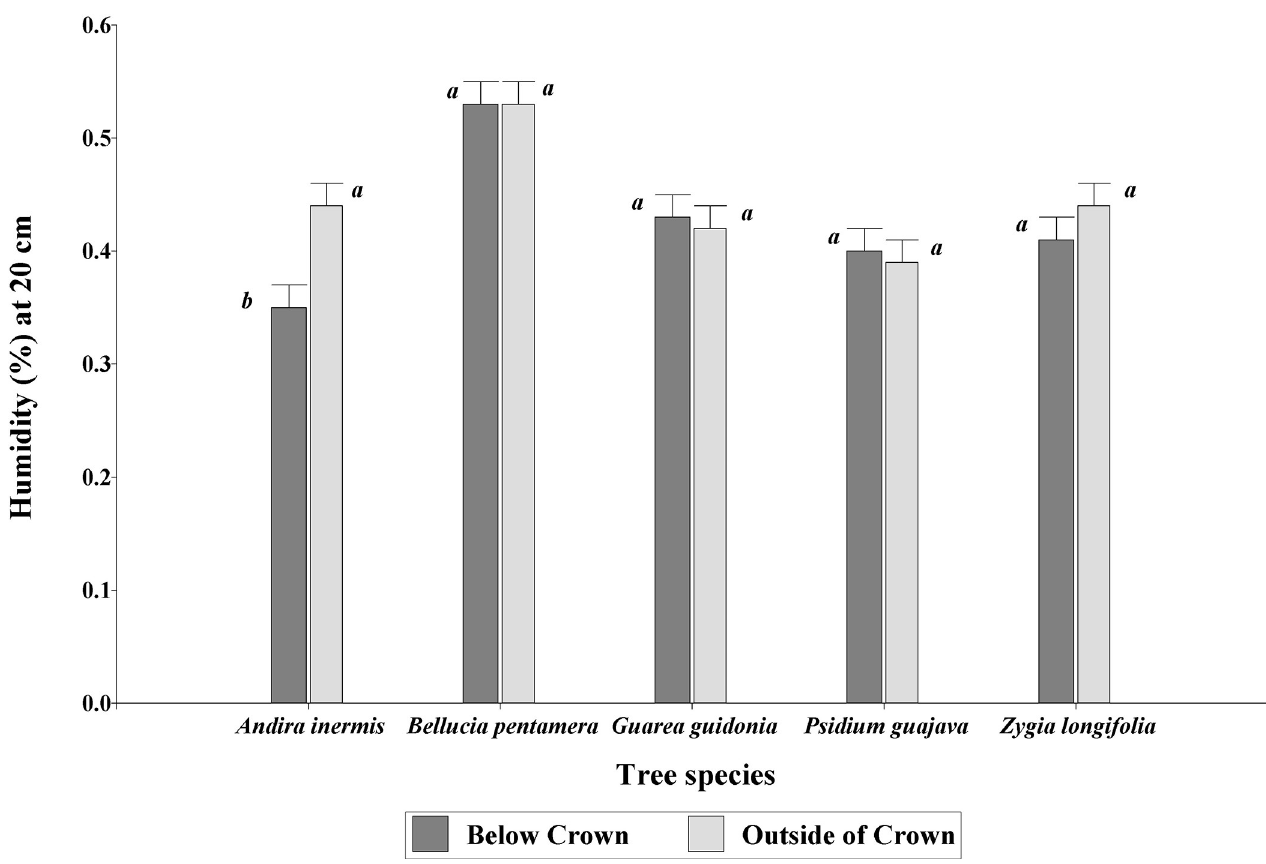
Fig 4. Percentage of soil moisture for the combination of tree species by distance at 20 cm depth in grazing areas of pastures in the Colombian Amazonian piedmont. Equal letters within species indicate equal means (P >